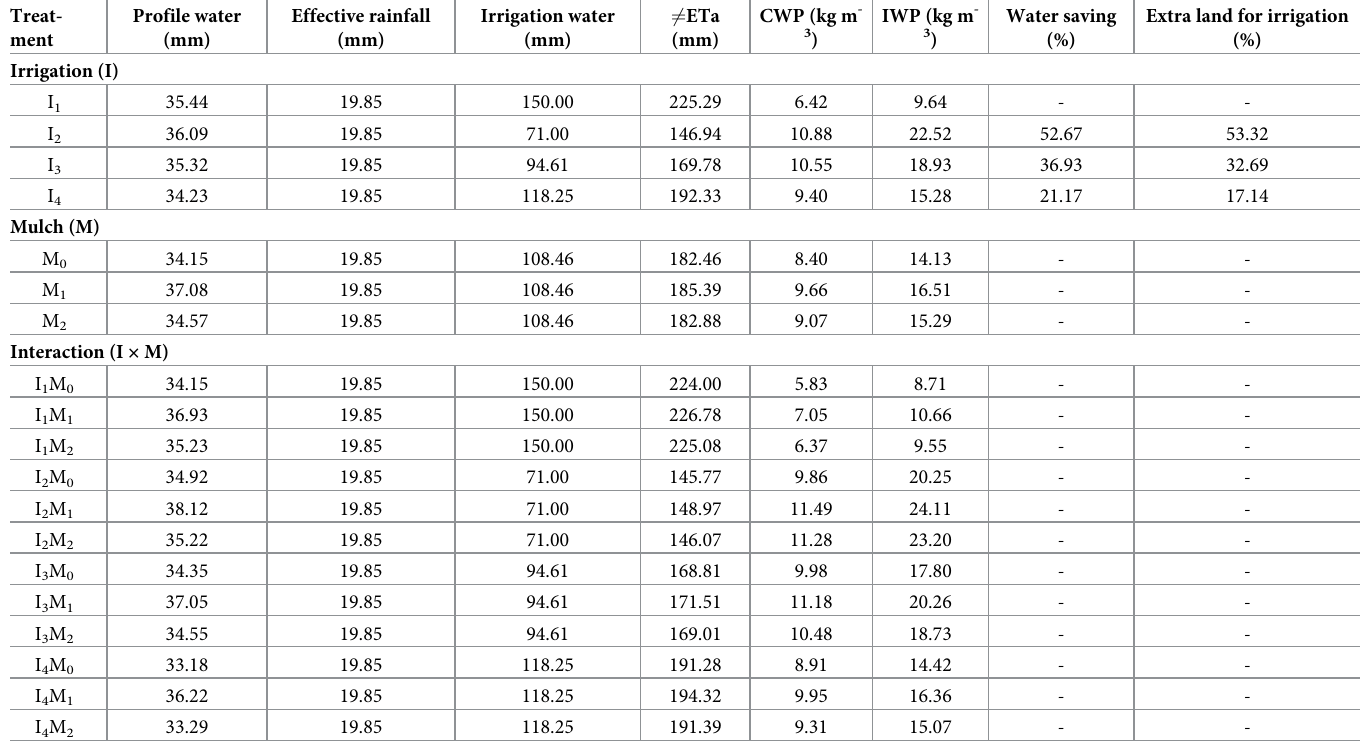
Table 4. Water balance components, seasonal actual crop evapotranspiration (ETa), crop water productivity (CWP), irrigation water productivity (IWP) and water saving for broccoli under different levels and methods of irrigation and mulches (average data of 3-year). Treat- Profile water Effective rainfall ment (mm) (mm)